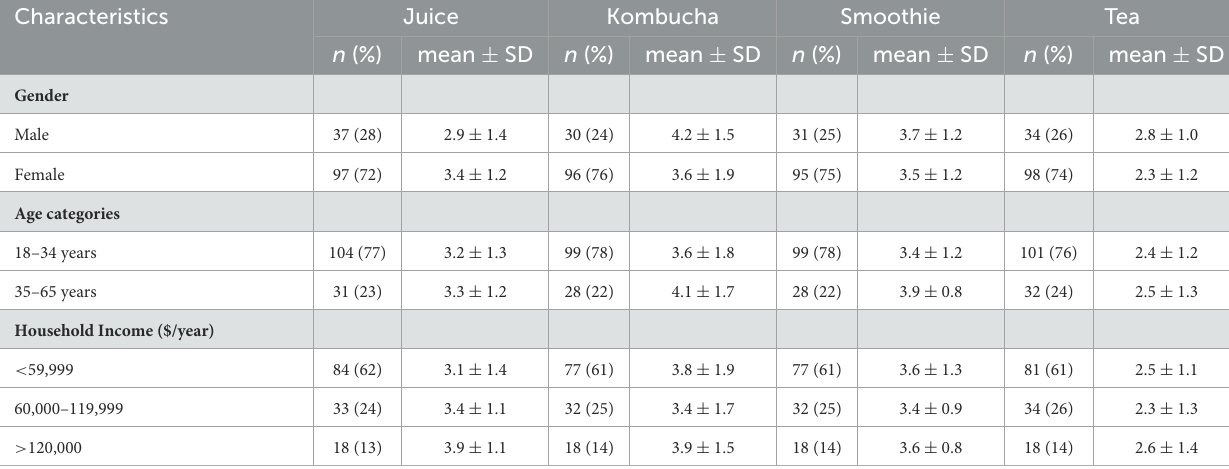
TABLE 4 Rank of reasons to why participants consume hibiscus products. Reason to consume hibiscus products